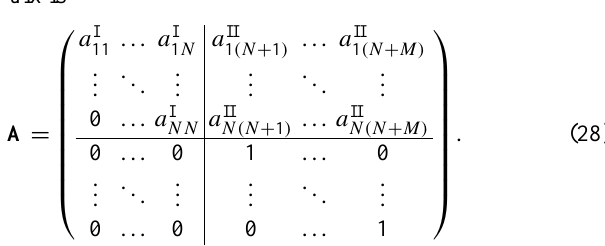
Fig. 4a: Example of the error propagation of a mobility par- ticle size spectrometer PNSD, Hohenpeissenberg, 23.02.12, one-hour average 0:00 - 1:00, EPMD (black) in plain con- centration (secondary y-axis) and PNSD (red). The fictive relative error of the results increases for sampling points in- fluenced by multiple charge correction from 10% to 15%